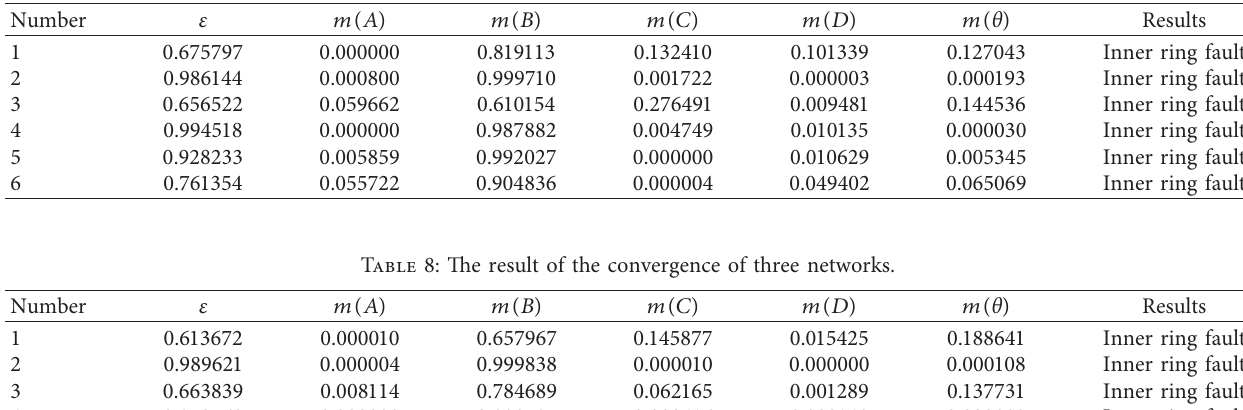
Figure 10: Fusing by the IDSET method. Table 7: The result of the convergence of BPNN and RBGNN.